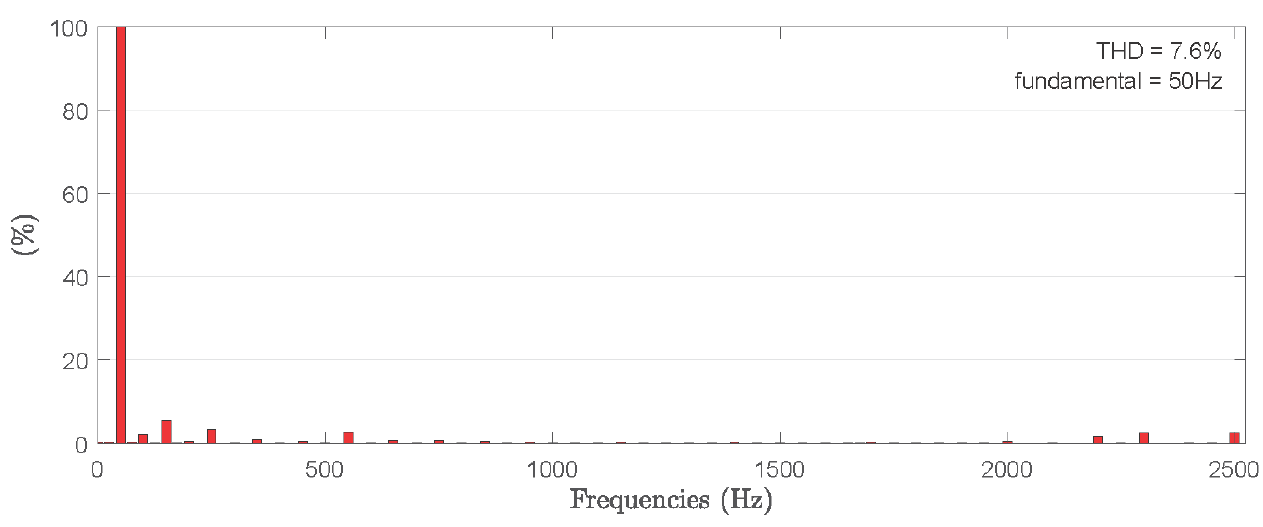
Table 3. Active and reactive power results with 50 Hz at the test bench.